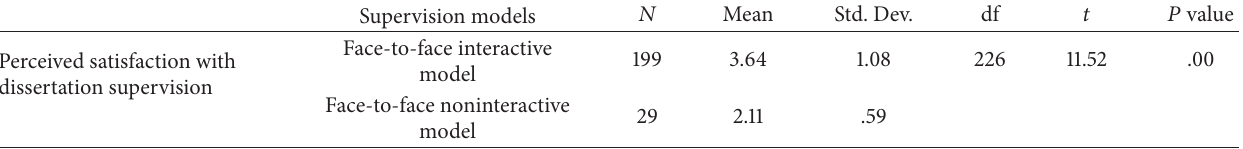
Table 4: 𝑡 -test for difference in doctoral students’ satisfaction with dissertation supervision by two models of dissertation supervision.